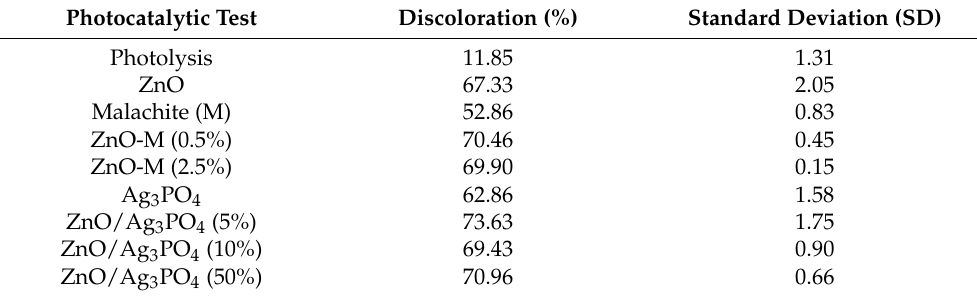
Table 5. Discoloration of the handmade textile staining wastewater samples after 240 min of photo- catalytic treatment.